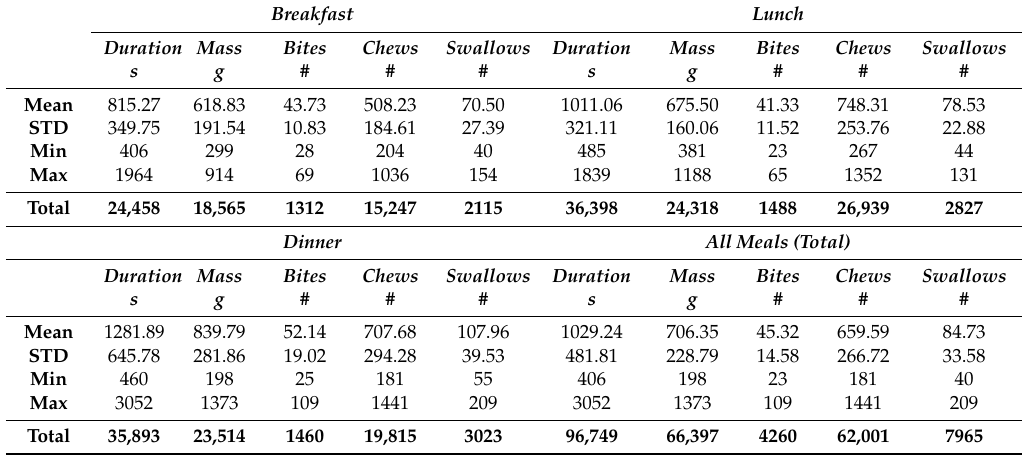
All Meals (Total)